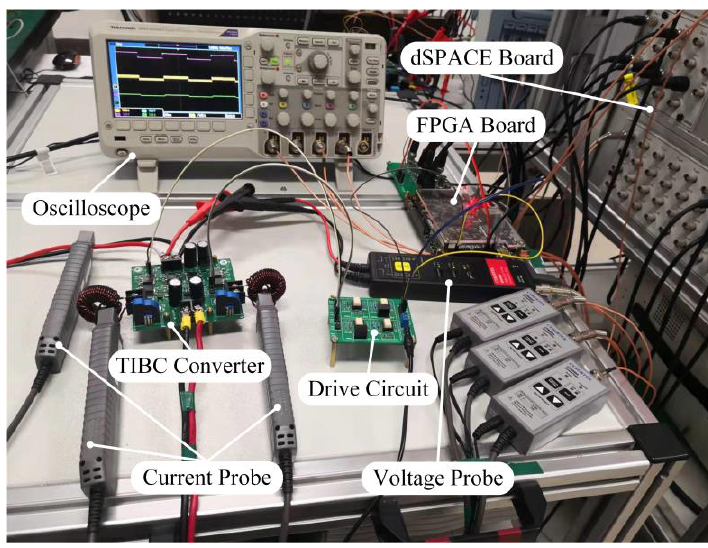
Figure 10. Experimental platform.